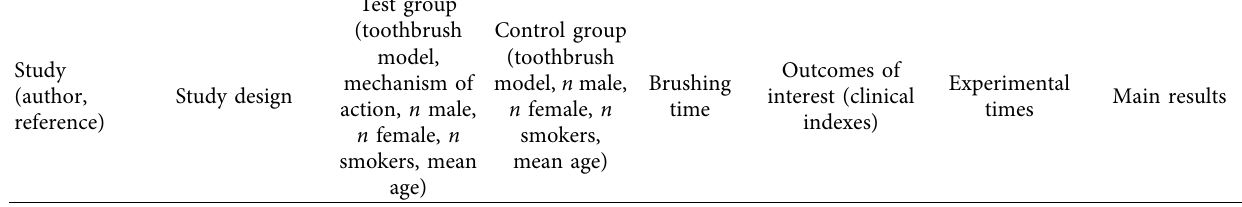
Table 3: Summary of studies that have addressed adverse effects of powered versus manual